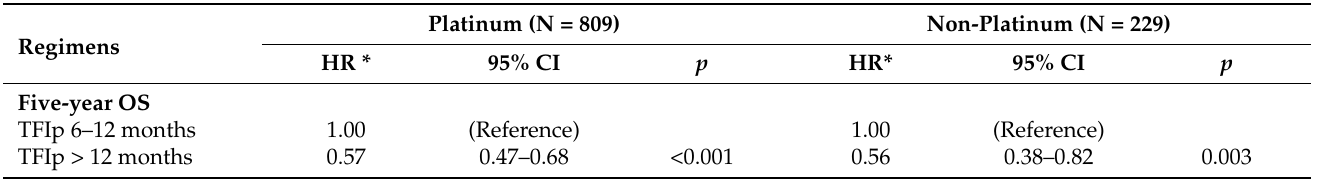
Table 4. Five-year OS of 1038 recurrent advanced EOC patients, stratified by platinum-based combinational or non-platinum single regimen with different platinum therapy-free